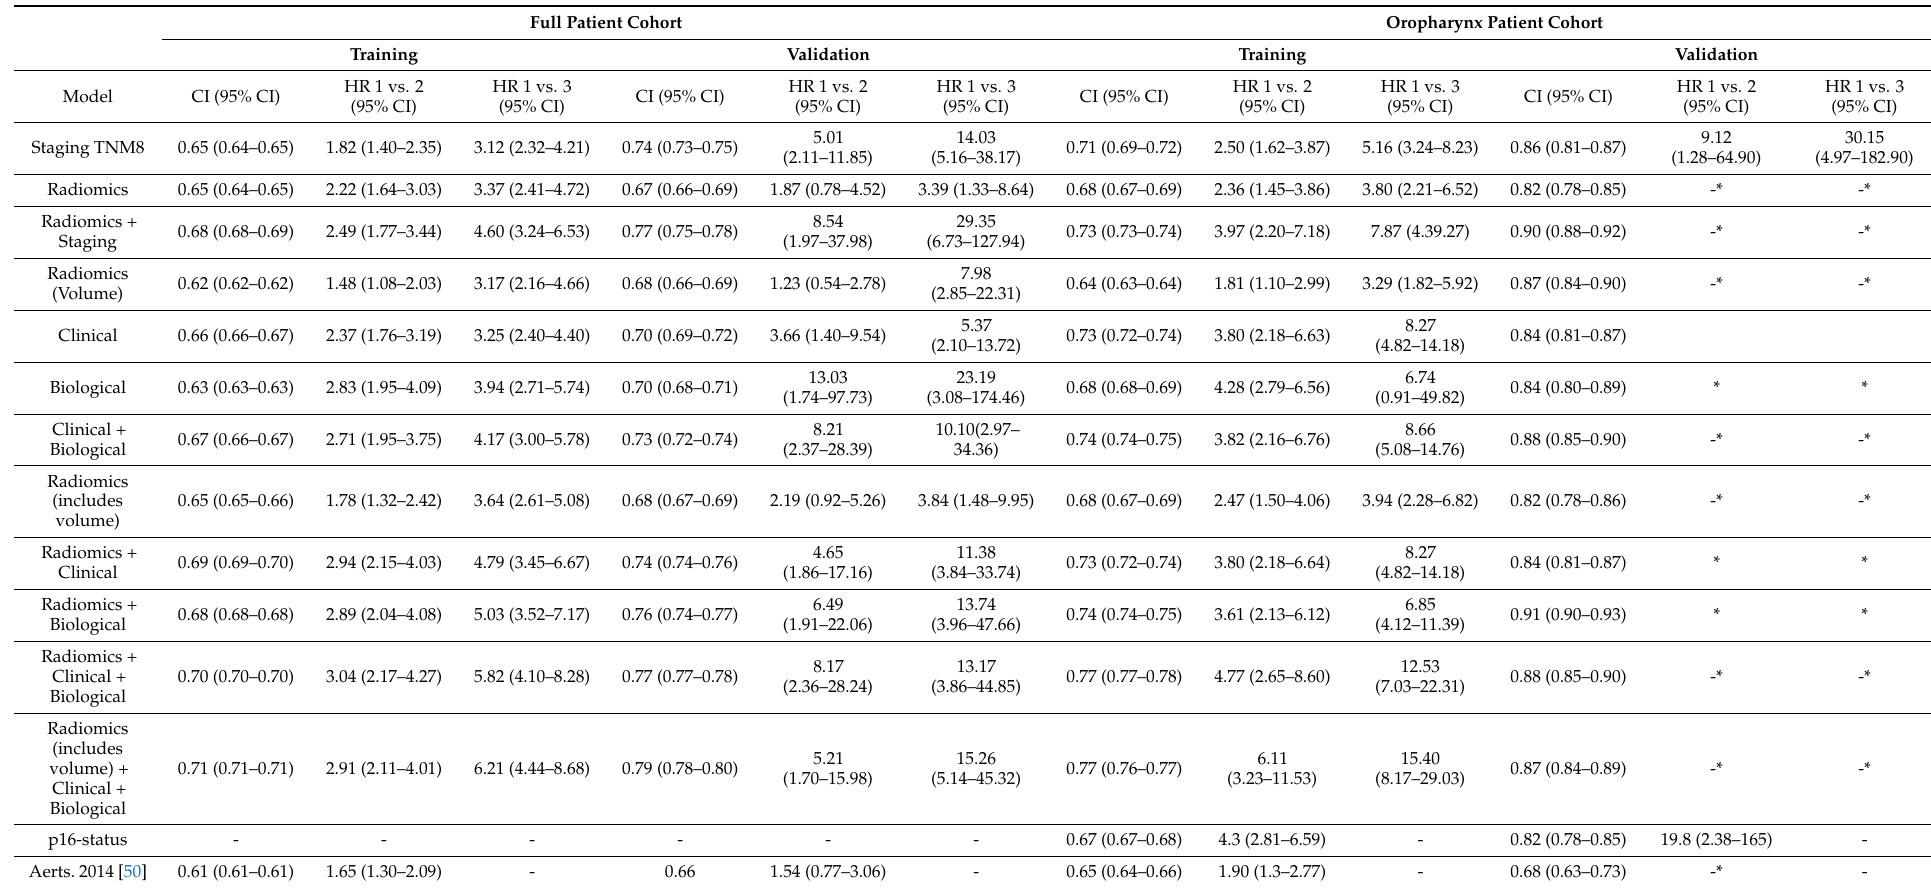
Table 3. Performance overview of all trained and/or validated models, showing Harrell’s CI and HR values for each model. The left side shows the models for the full patient cohort, both training ( n = 666) and validation ( n = 143), the right the oropharynx patient cohort, both training ( n = 294) and validation ( n = 51). * indicates no HR could be calculated, as the low-risk group did not have any events